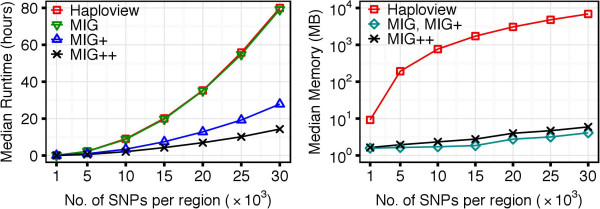
Performance of the algorithms with the WP method, when applied to the 1000G dataset. MIG + and MIG ++ show substantially better runtime than MIG and Haploview. All versions of the MIG algorithm significantly outperforms Haploview in memory usage and, therefore, are able to handle densely genotyped and genome-wide data.